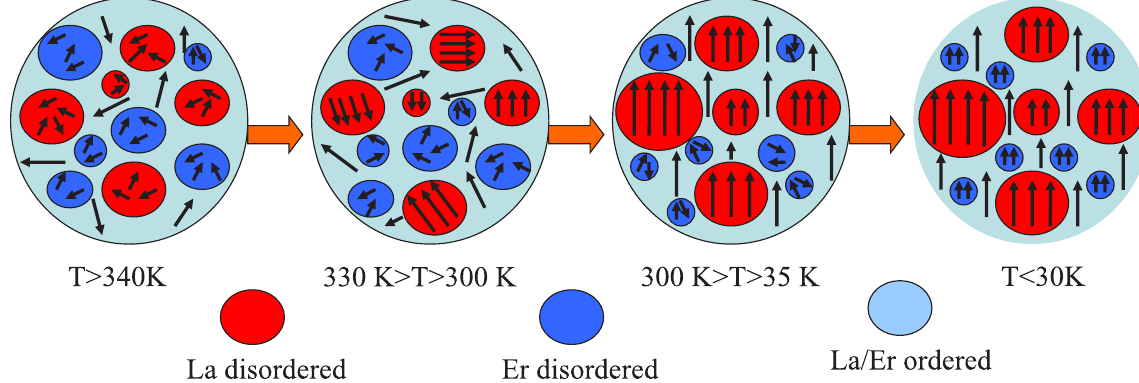
Figure 6. A schematic diagram of the proposed model to describe the magnetic state of La 0.6 Er 0.1 Sr 0.3 MnO 3 system in different temperature